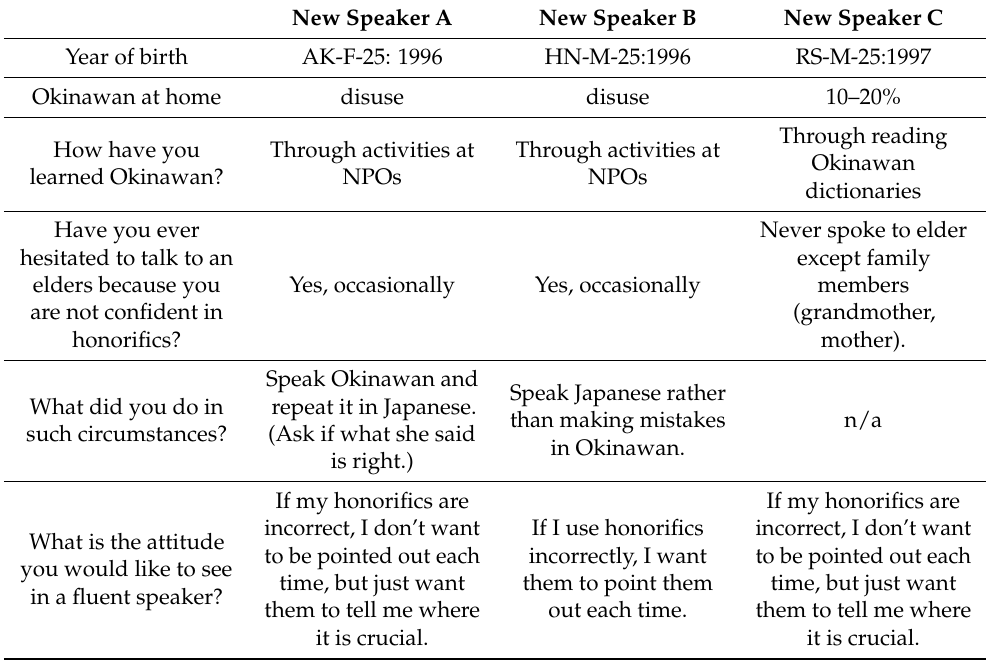
Table 6. Sociolinguistic Profile of New Speakers.